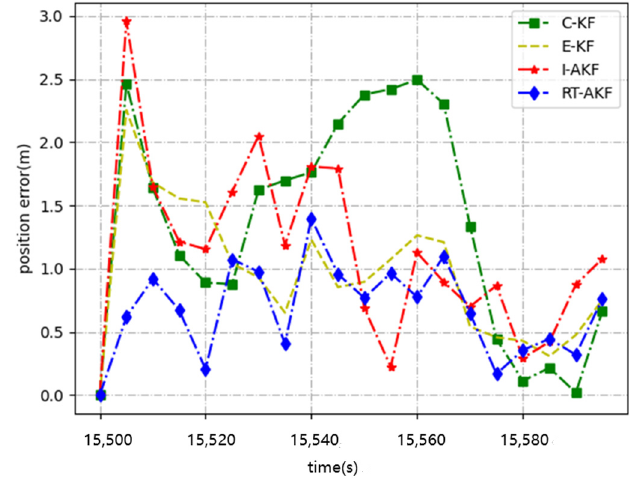
Figure 14. The positioning errors of GNSS/INS tightly coupled integrated by different methods in segment #4.